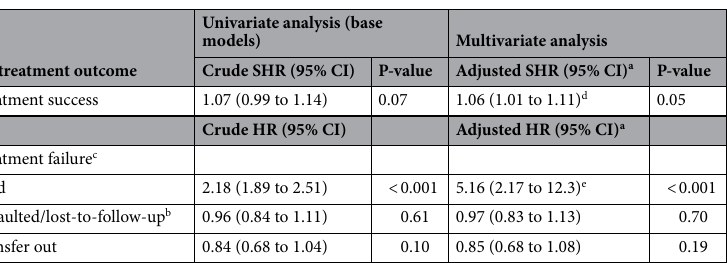
Table 4. Univariate and multivariate analysis of TB treatment outcomes associated with diagnosis of TB at time of starting anti-TB treatment. a Adjusted for apriori confounders: age, gender, patient type, TB type (P/ EP), HIV status, treatment regimen and BMI groups, SHR sub-distribution hazard ratios from Fine & Gray competing risk regression model, HR hazard ratios from Cox proportion regression models. b Hazard ratios are from the Gompertz parametric regression model. c No measures of association was estimated for treatment failure because of obvious bias in classifying the clinically diagnosed patients who had a negative sputum test when starting treatment. d The adjusted regression models included the HIV interaction term. e The adjusted regression models included the HIV, age interaction